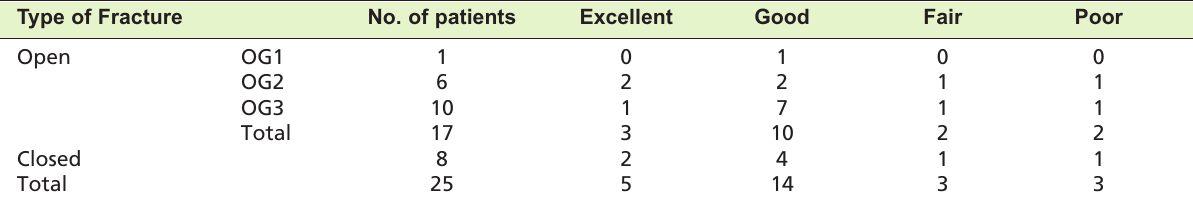
Result in open and closed fractures Table II: